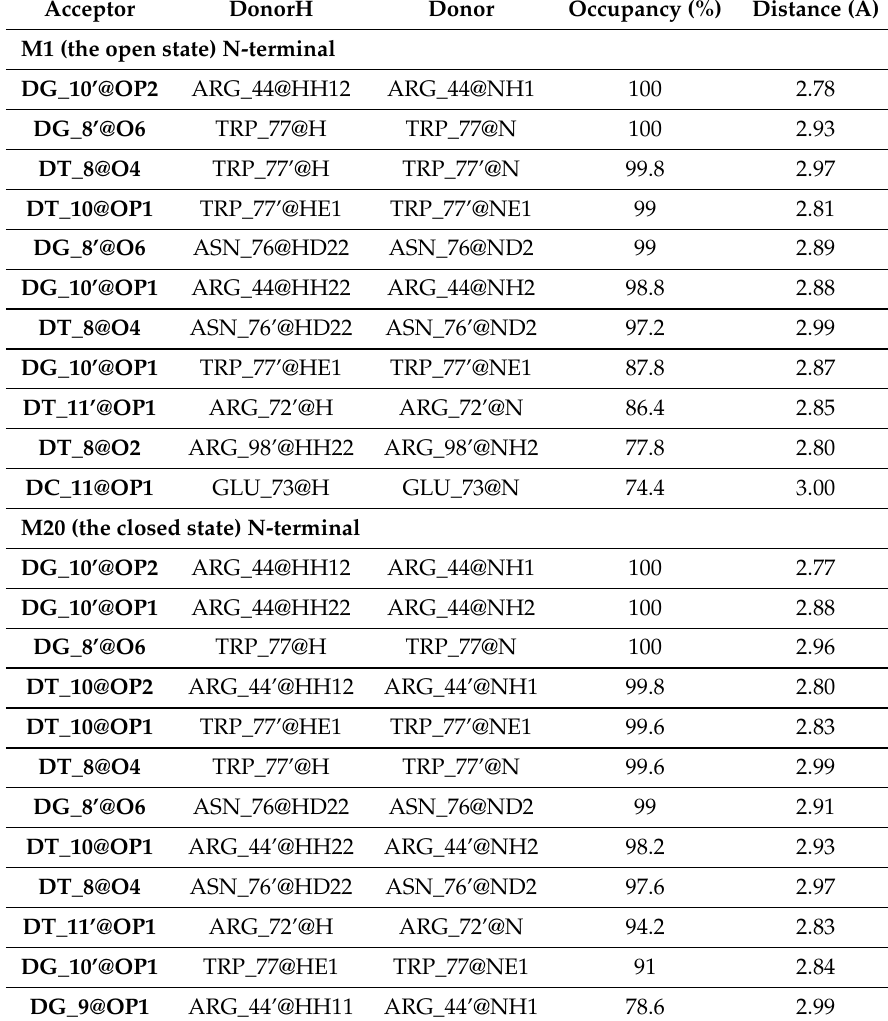
Table 2. Hydrogen bonds between EndoMS/NucS and dsDNA of the N-terminal domains for M1 and M20 in the last 20